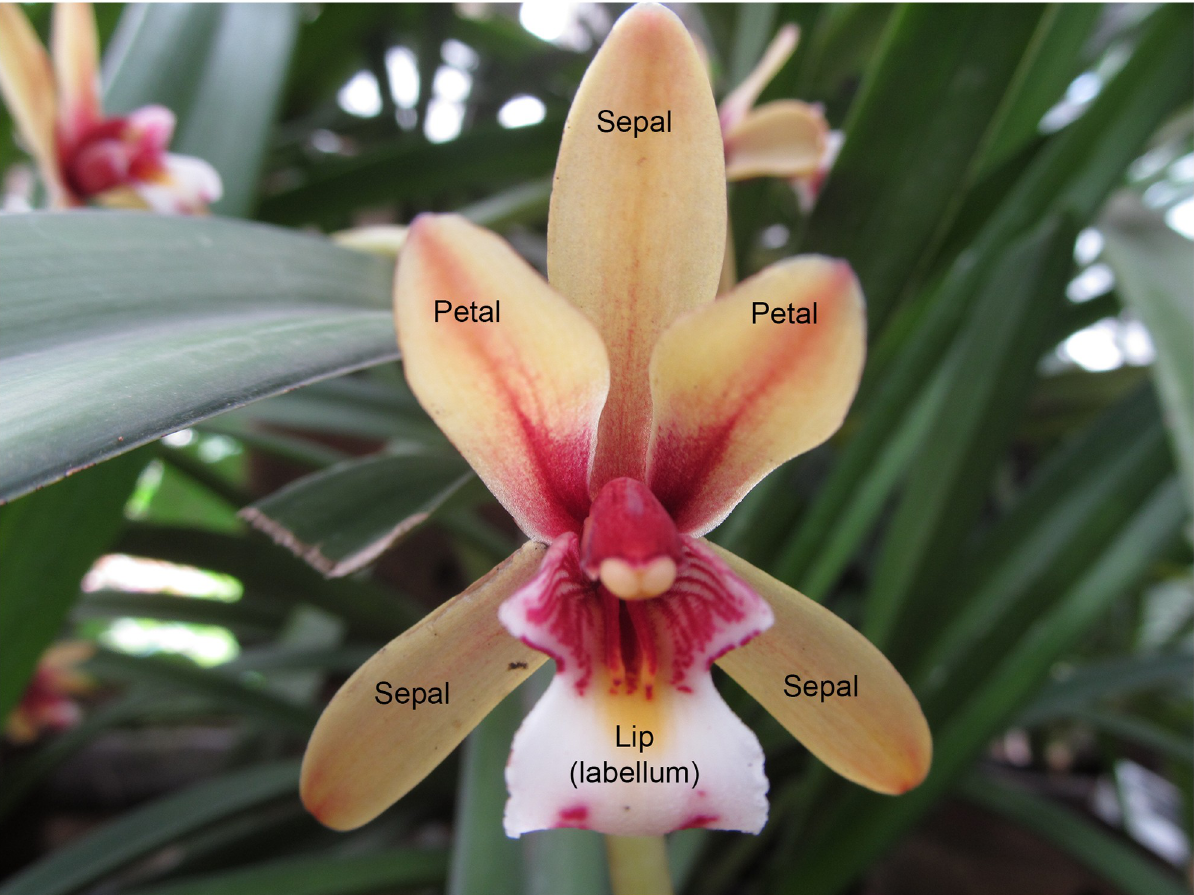
Fig 1. Parts of an orchid flower. The flower is made up of sepals and petals; there is only one labellum and it may have its own separate color.